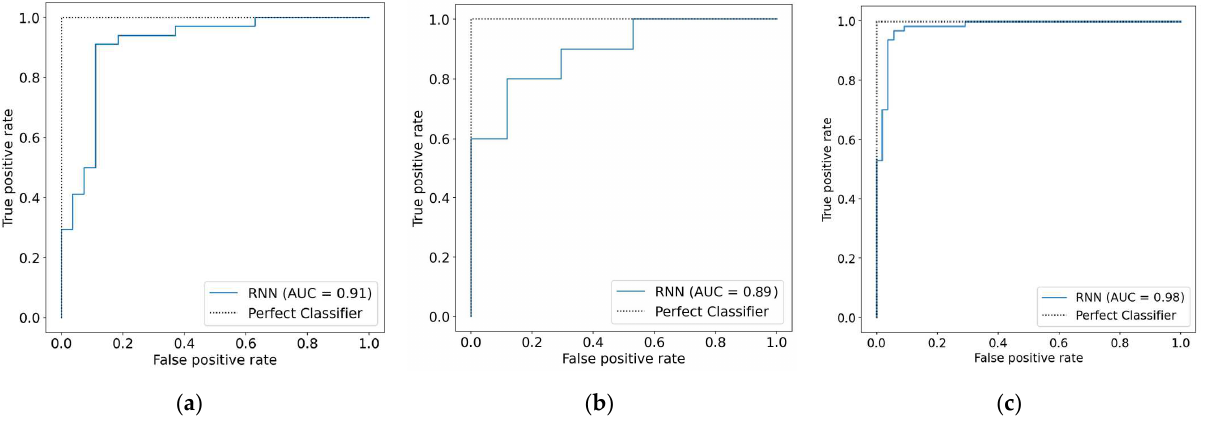
Table 5. The Bi-LSTM model performance analysis.